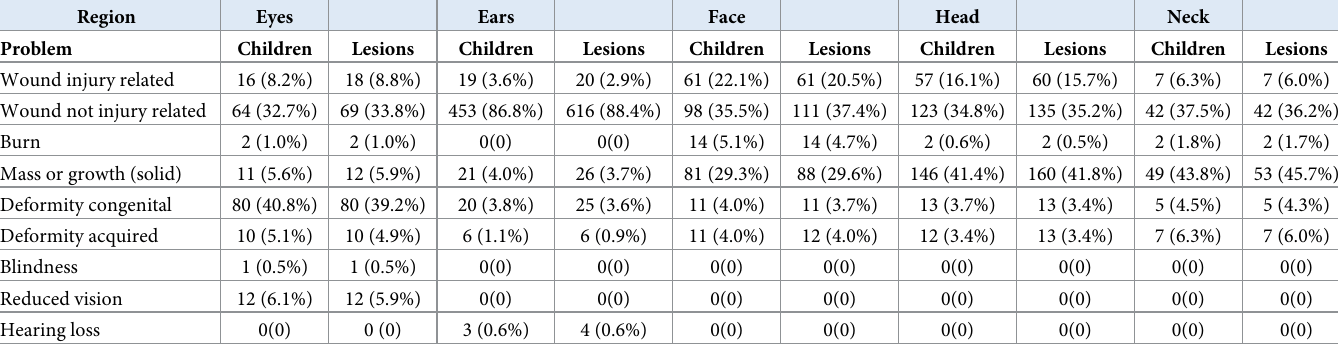
Table 3. Lesions on head and